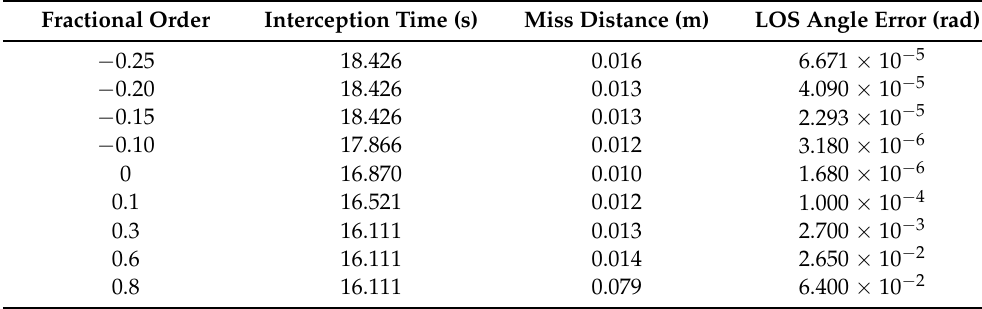
Table 2. Interception times, miss distances, and LOS angle errors of the proposed guidance laws under different fractional orders in case